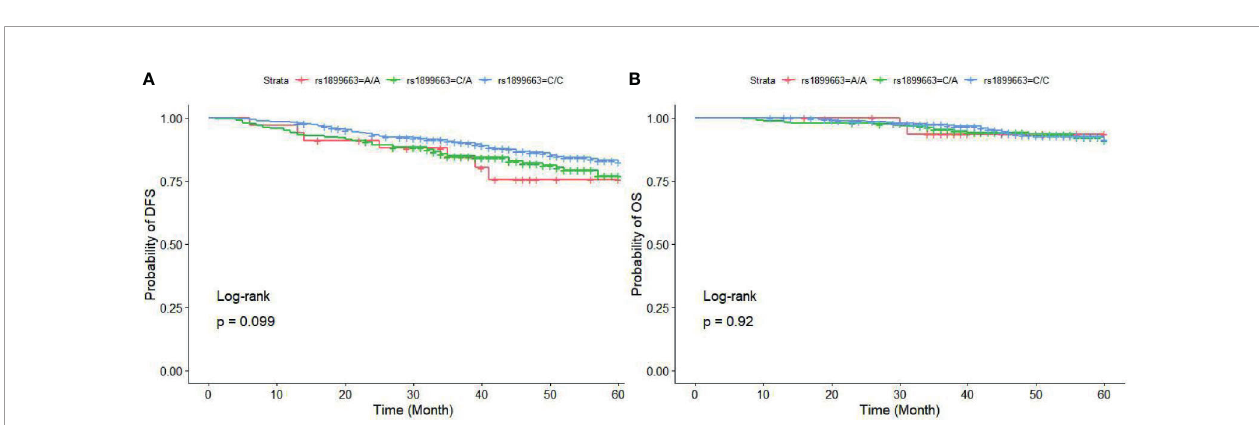
FIGURE 2 | DFS (A) and OS (B) for BC patients with different genotypes of HOTAIR rs1899663. BC, breast cancer; HOTAIR , HOX transcript antisense RNA; DFS, disease-free survival; OS, overall survival. The three curves of DFS/OS are not statistically different, the P value is 0.099 and 0.92 respectively. However, subjects with CA genotype had a worse DFS compared to subjects with AA genotype (P =